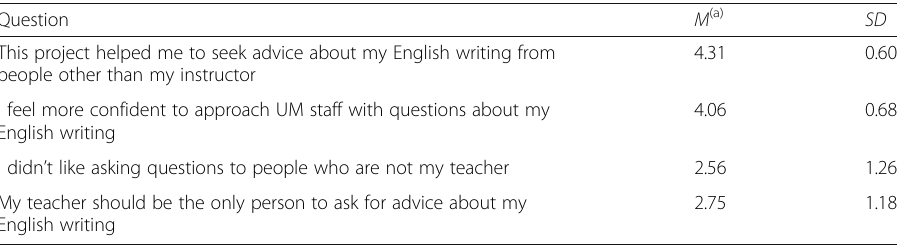
Table 5 Follow-up questionnaire autonomy items ( n = 16) Question M (a)